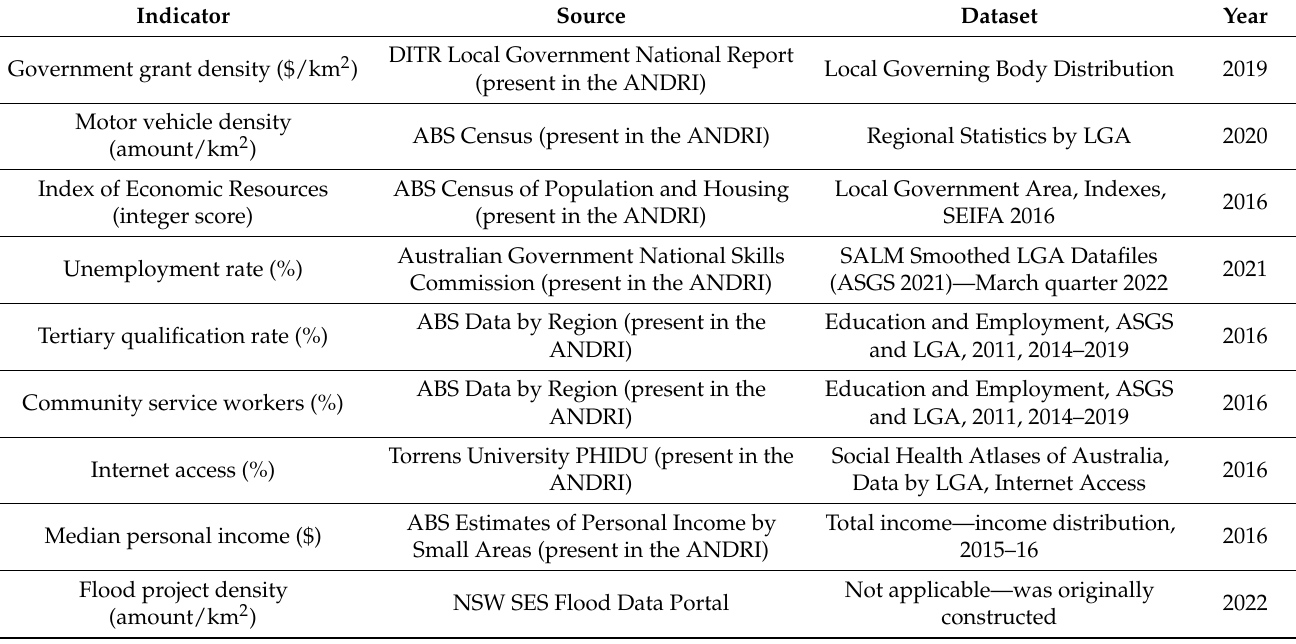
Table 1. Metadata for each flood resilience indicator in the study design.